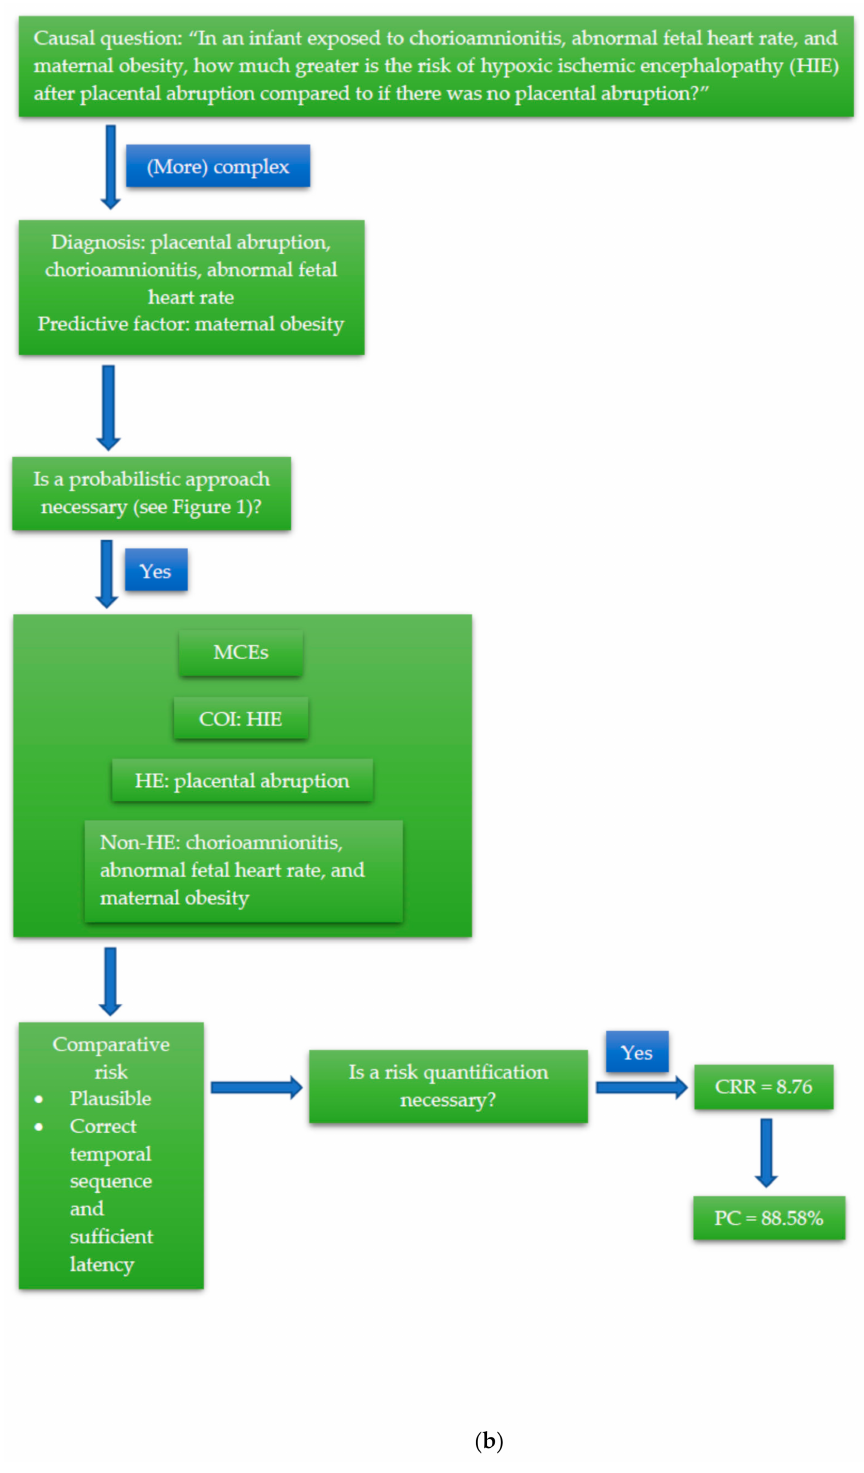
Figure 2. ( a ) Schematic of the INtegration of Forensic Epidemiology and the Rigorous EvaluatioN of Causation Elements (INFERENCE) approach. ( b ) Example of the INFERENCE approach in causal analysis of a case of fetal hypoxic ischemic encephalopathy